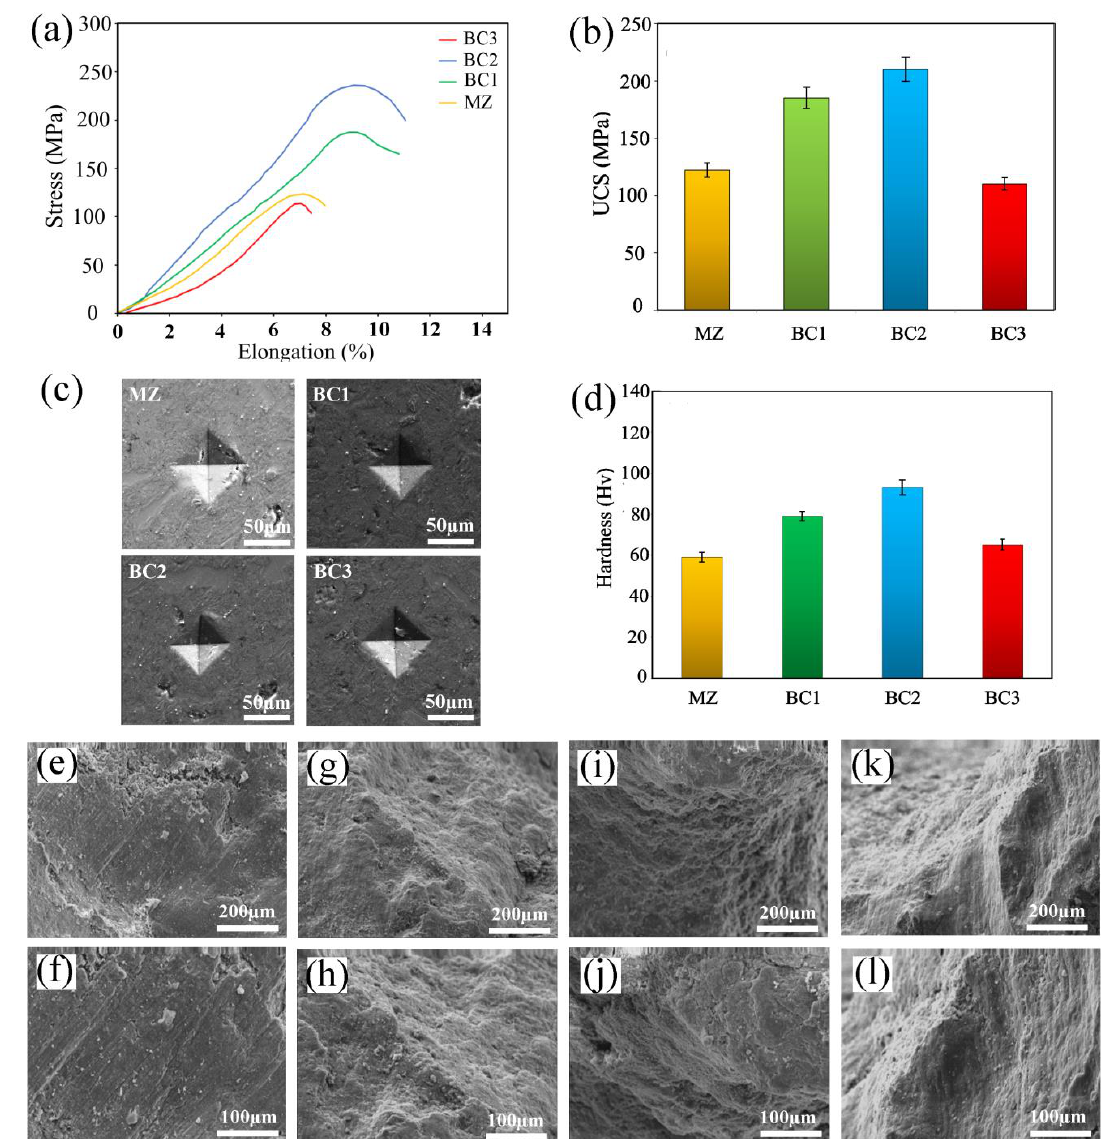
Figure 7. ( a ) Compressive curves ( b ) ultimate compressive strength (UCS) diagram, ( c ) surface morphology after deformation by press indentation (( d) the value of microhardness, ( c – j ) SEM images of the fracture surface of the composites after the compressive strength test: ( e ) MZ ×150; ( f )